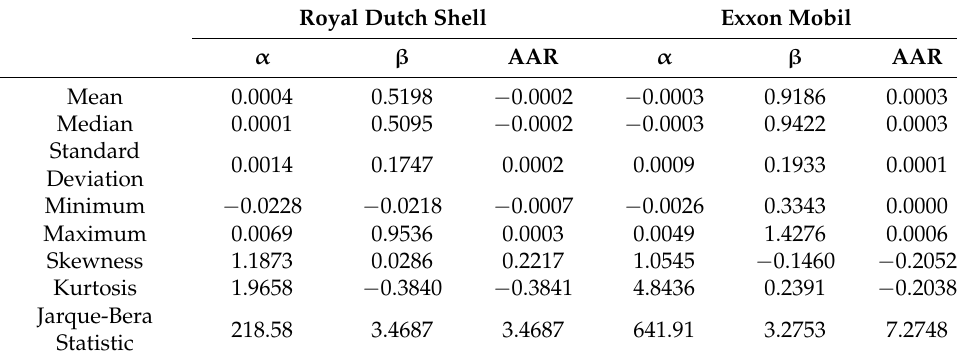
Table A3. Descriptive statistics of the alpha, beta and average abnormal returns regarding the induced seismicity in the US in the estimation window (day -100 to day -1), ( df = 551).